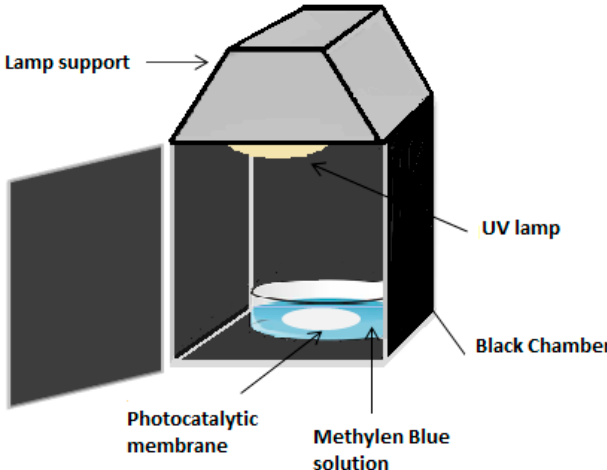
Figure 10. Schematic picture of the photocatalytic set-up.